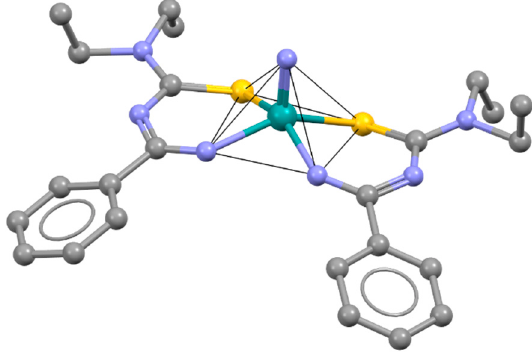
Figure 4. Structure of TcN(HEt 2 tcb) 2 .